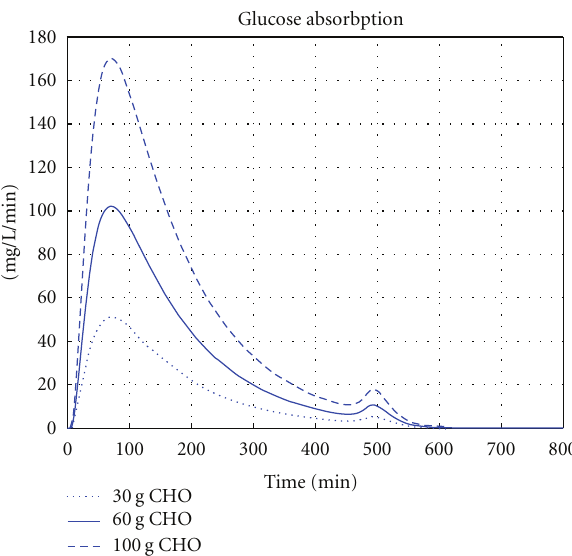
Figure 7: Absorption scenarios taken into account based on the meal model of Dalla Man et al. [15].